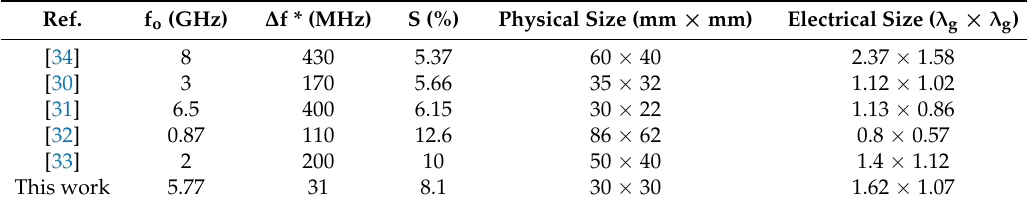
Table 4. Performance comparison between our proposed TM 02 -mode QMSIW resonator and other microwave dual/multichannel sensors.